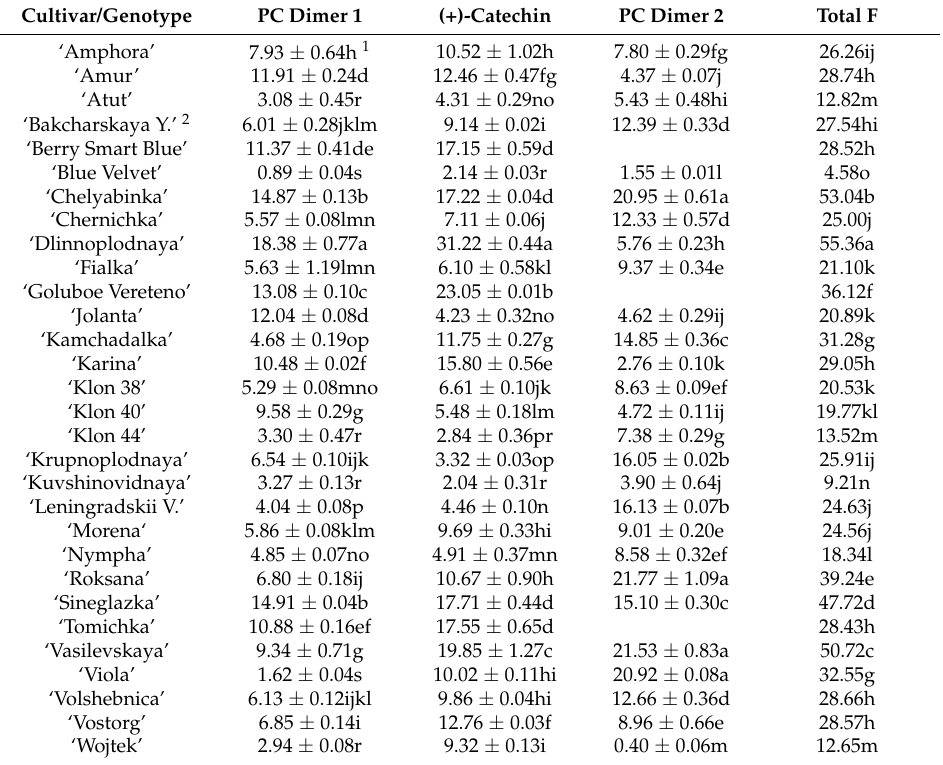
Table 5. Flavan-3-ol derivatives content (mg/100 g fw) of different blue honeysuckle cultivars and